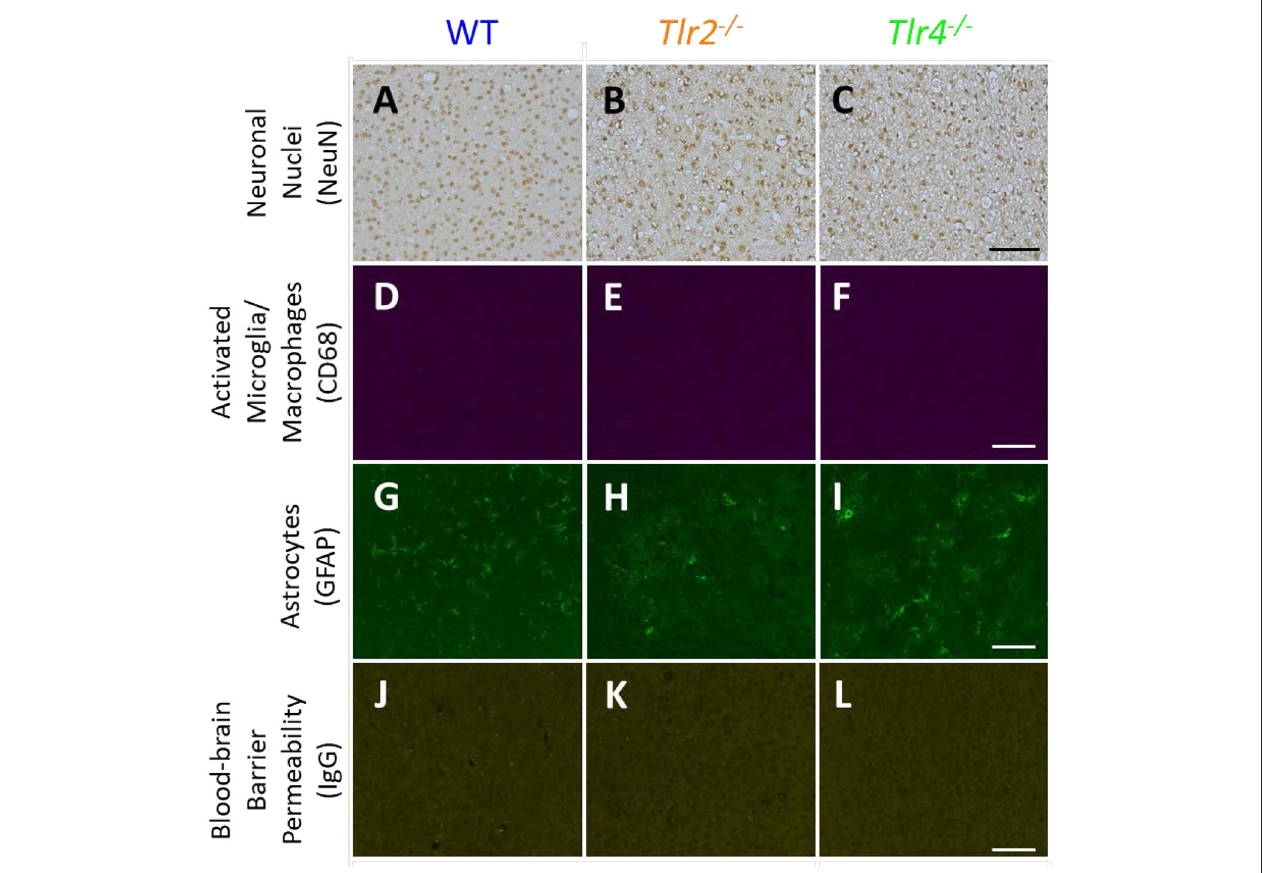
FIGURE 1 | Immunohistochemical staining in sham animals. WT (A,D,G,J) , Tlr2 − / − (B,E,H,K) , and Tlr4 − / − (C,F,I,L) mice without implanted probes were stained for neuronal nuclei (NeuN, A-C ), activated microglia and macrophages (CD68, D–F ), astrocytes (GFAP, G–I ), and blood-brain barrier permeability (IgG, J–L ). Scale bars are provided for each row of images, scale = 100 µ